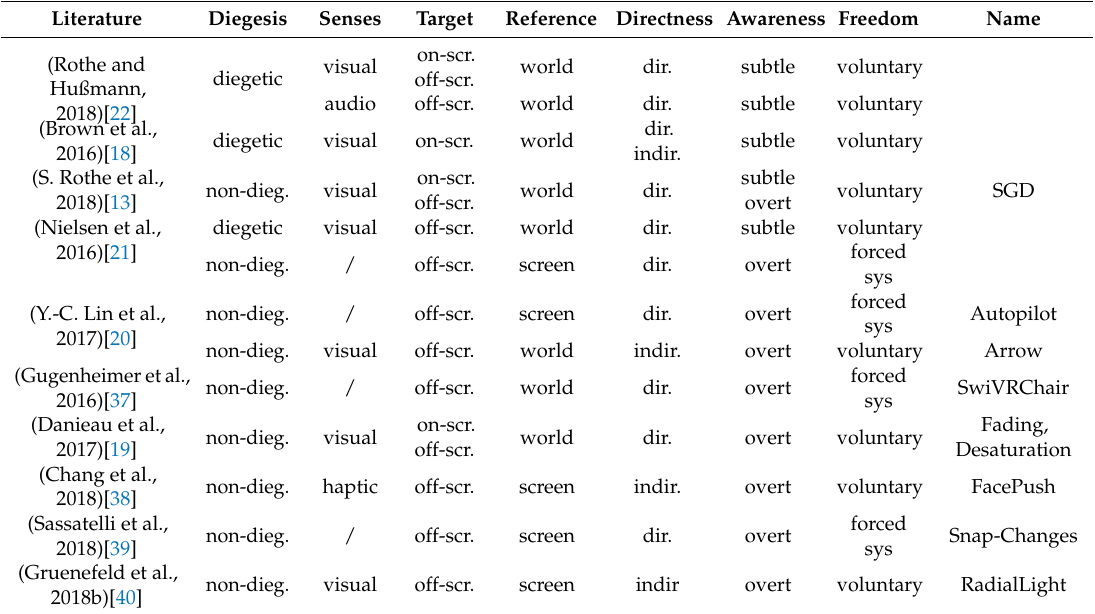
Table 10. Guiding methods evaluated for CVR and the attributes of the